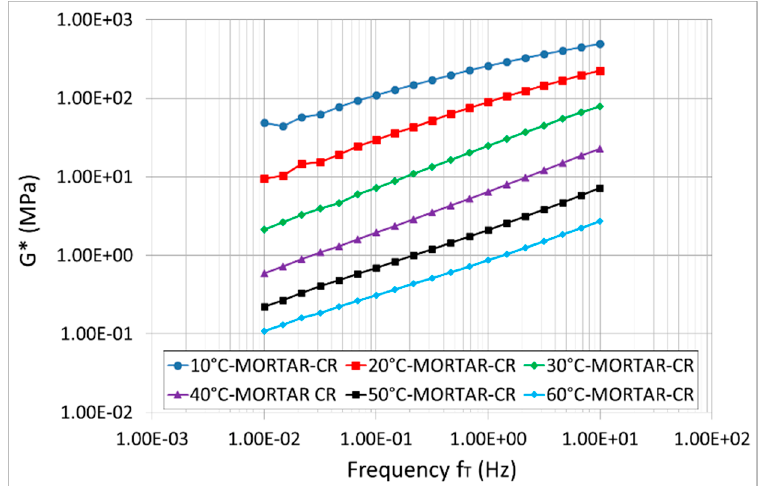
Figure 5. Isothermal curve for MORTAR-CR. Table 9. TTsf for MORTAR-CR master curve at 20 °C.